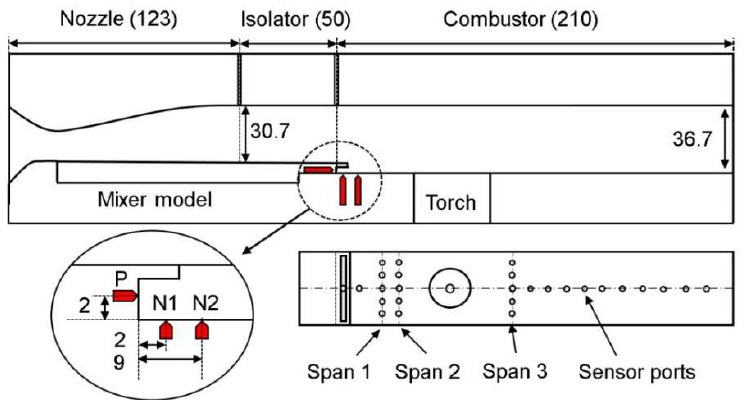
Figure 1. A rectangular duct-type supersonic combustor model (unit: mm): P—Parallel injector, N1—Normal 1 injector, N2—Normal 2 injector. N1—Normal 1 injector, N2—Normal 2